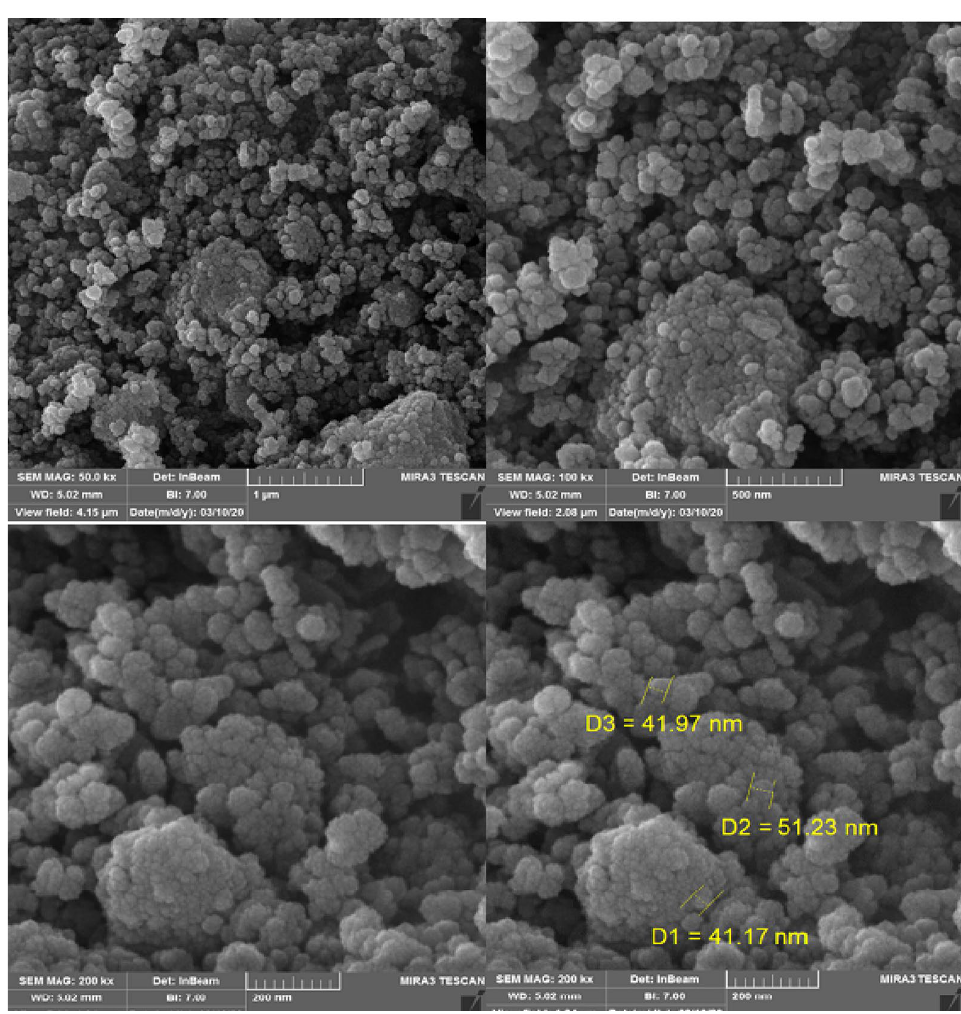
Figure 7. Scanning electron microscope (SEM) images of